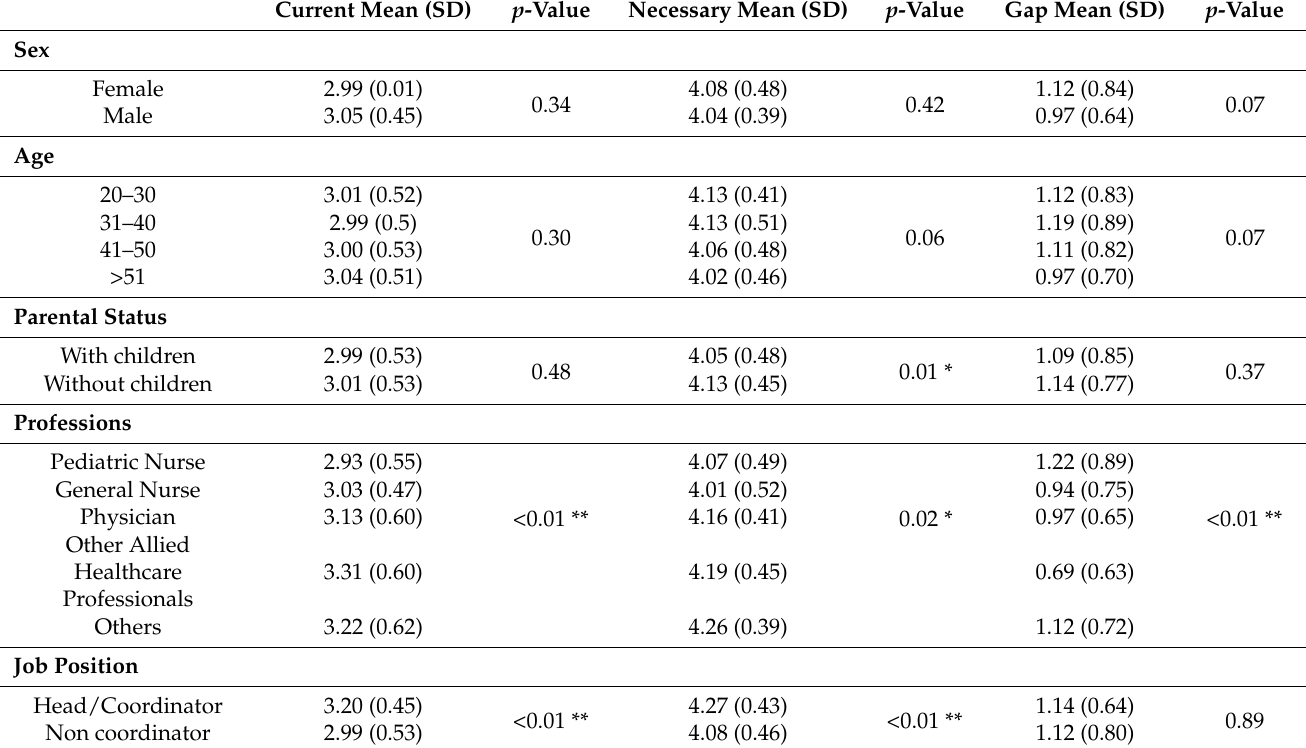
Table 5. Comparisons of FCCQ-R@it-NICU total mean score by participant